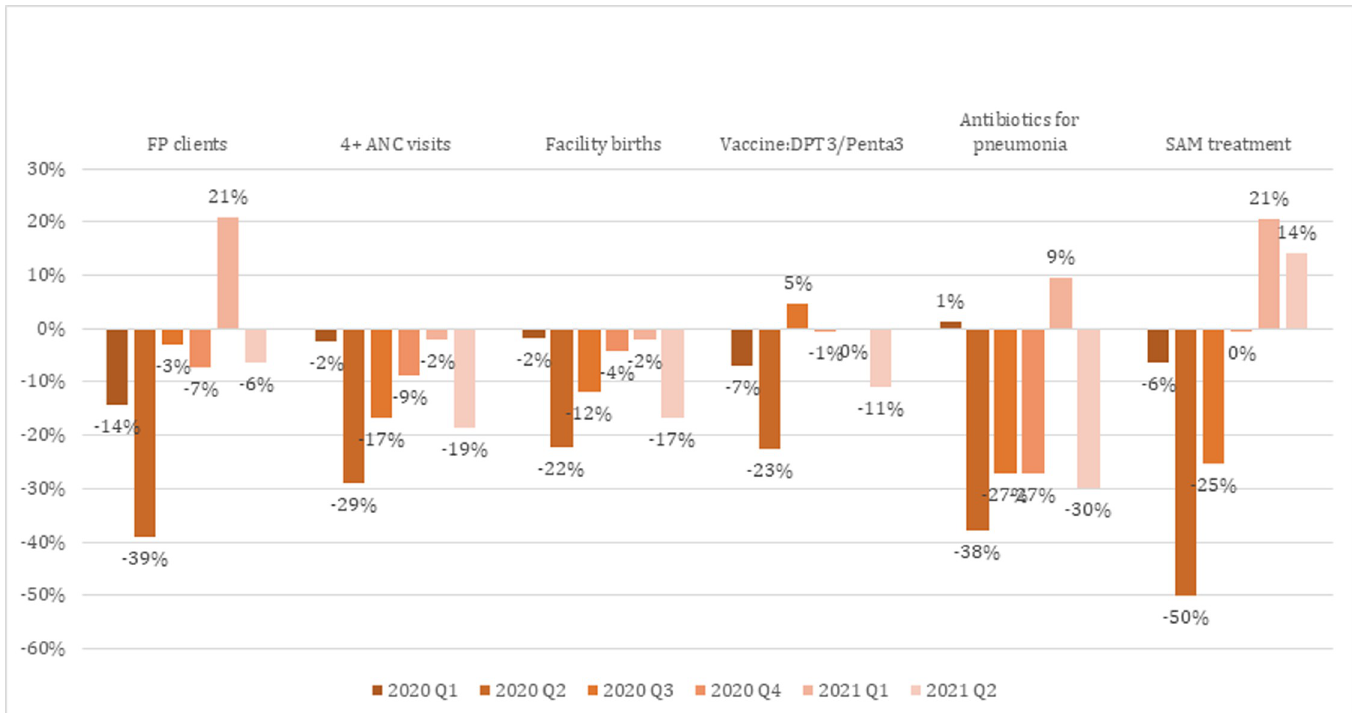
Fig 1. Observed disruption in utilization of essential SRMNCH health services due to COVID-19 in South Asia, Jan 2020 to Jun 2021.